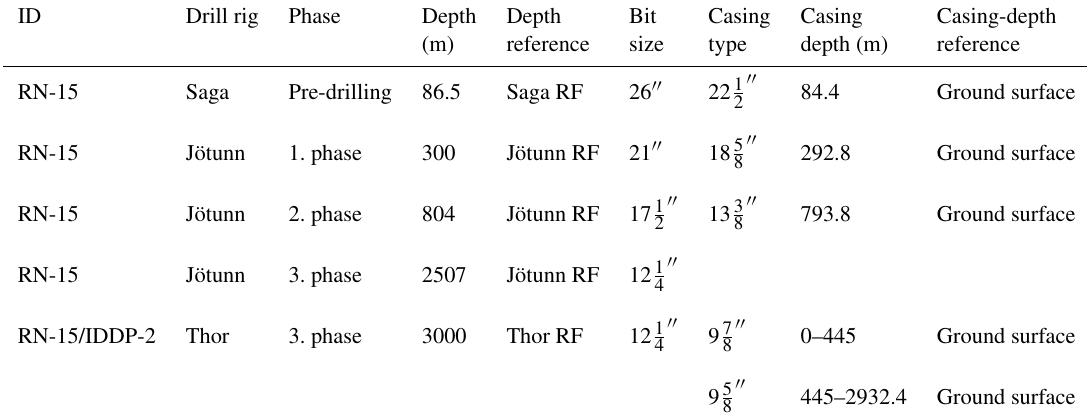
Table 1. Drilling and casing depths in well RN-15 and RN-15/IDDP-2.